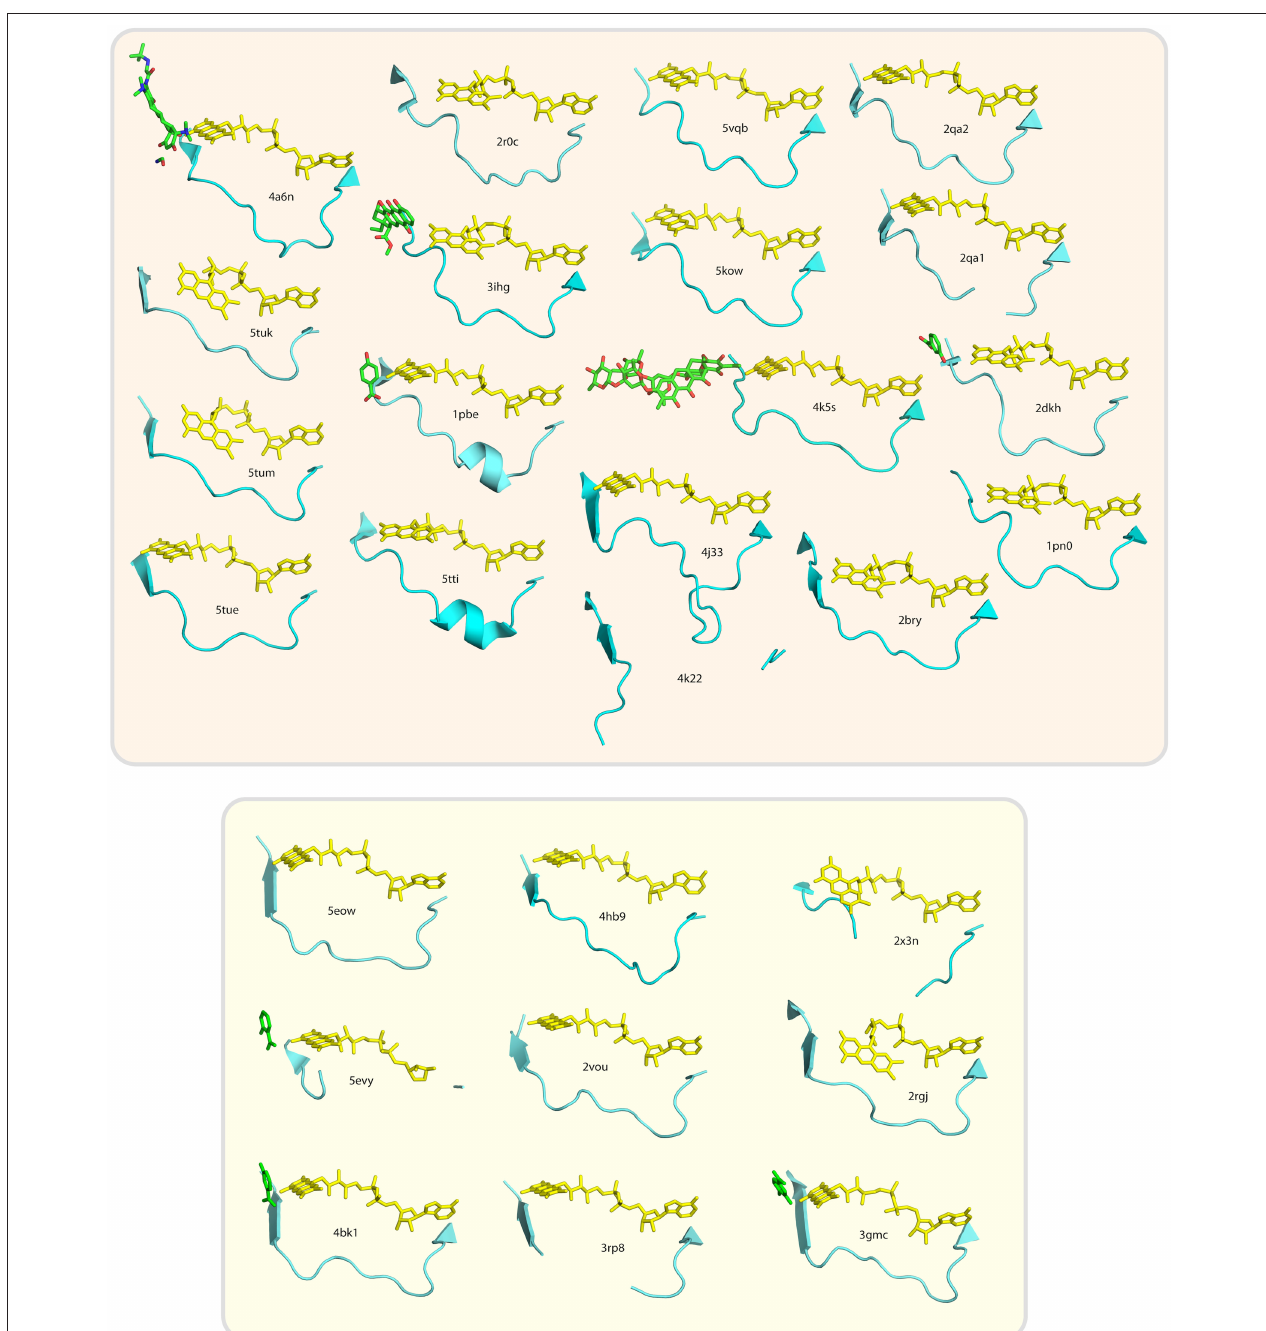
FIGURE 7 | Cartoon images of loop segment structures putatively involved in NAD(P)H binding of group A flavoprotein monooxygenases. Structures in the beige box (top) are NADPH-preferring enzymes, those in the yellowish box (bottom) are NADH-preferring enzymes. Substrates or inhibitors present in the used crystal structures are sketched in